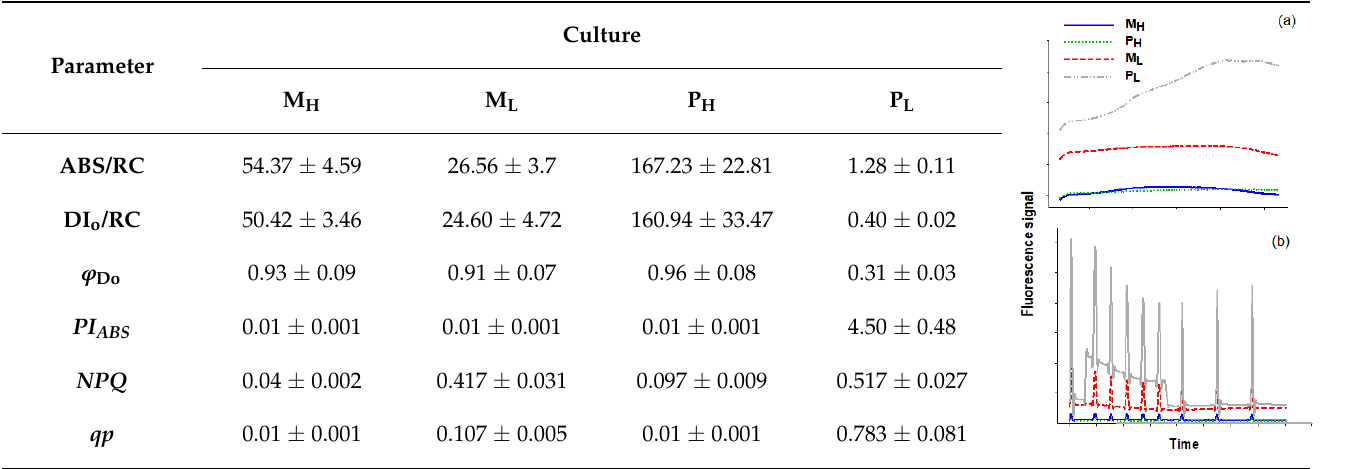
Table 2. Q A - re-oxidation kinetics of A. protothecoides cultivated under white light. Inset figures: Q A - re-oxidation kinetics without ( a ) and with 50 μM 3-(3,4-dichlorophenyl)-1,1-dimethylurea (DCMU) ( b ). Data represent the average ± SD of three replicates (n = 3). M H and M L stands for mixotrophy with high and low peptone, respectively, and P H and P L stands for photoautotrophy with high and low peptone, respectively). Kinetic